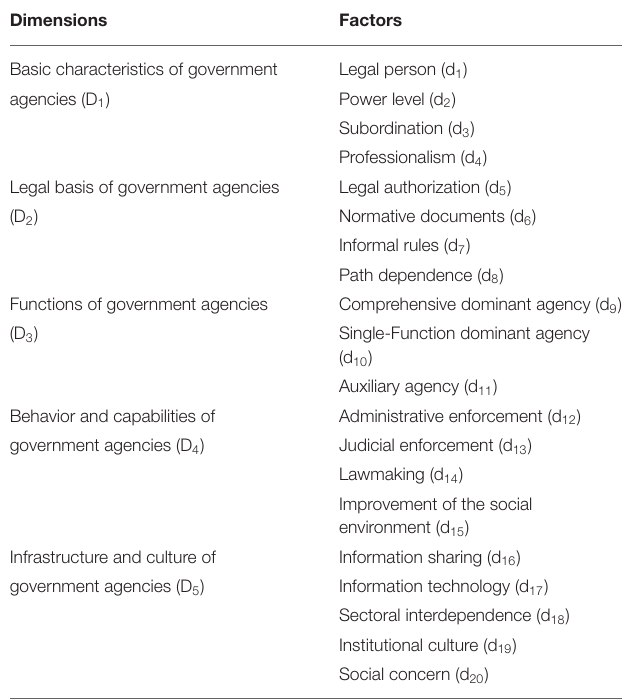
TABLE 1 | A set of dimensions and factors that affect public-public collaboration for food safety risk management is defined.